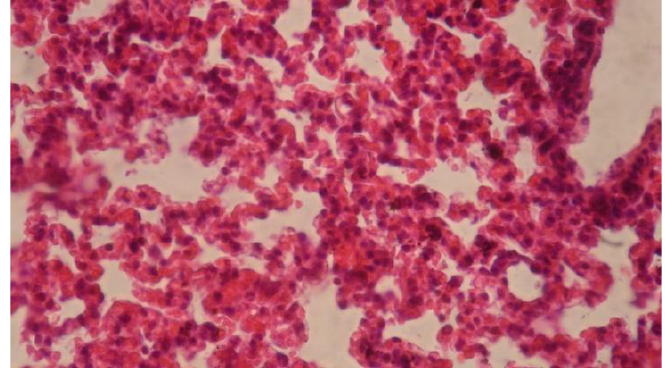
Fig. 3. Severe pulmonary hypertension of the alveolar wall (magnification 400) under the influence of engine oil containing 5000 mg/ kg copper nanoparticles.